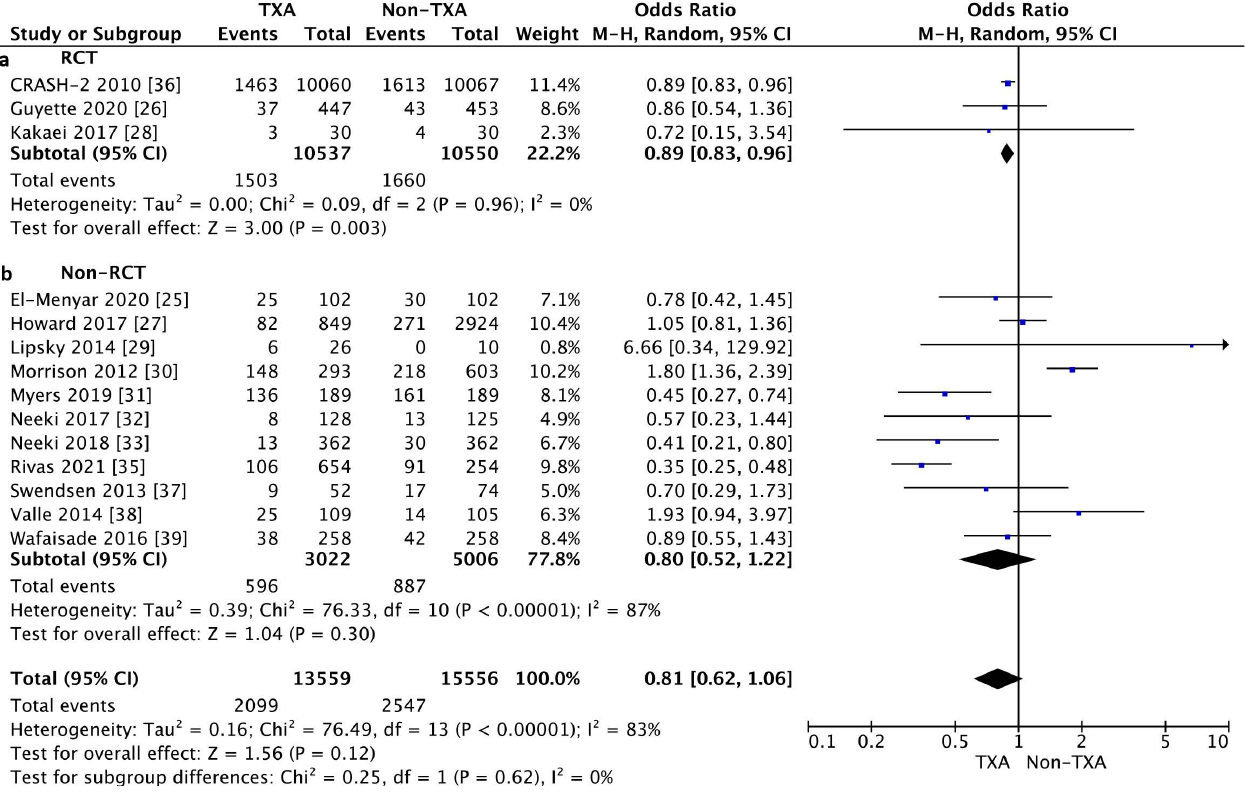
Figure 3. Forest plot of in-hospital mortality in the TXA group vs. the non-TXA group. ( a ) Randomized control trials (RCTs); ( b ) Non-randomized control trials. The center of each square represents the weighted odds ratio (OR) for individual trials, and the corresponding horizontal line stands for the 95% confidence interval (CI). The diamonds represent pooled